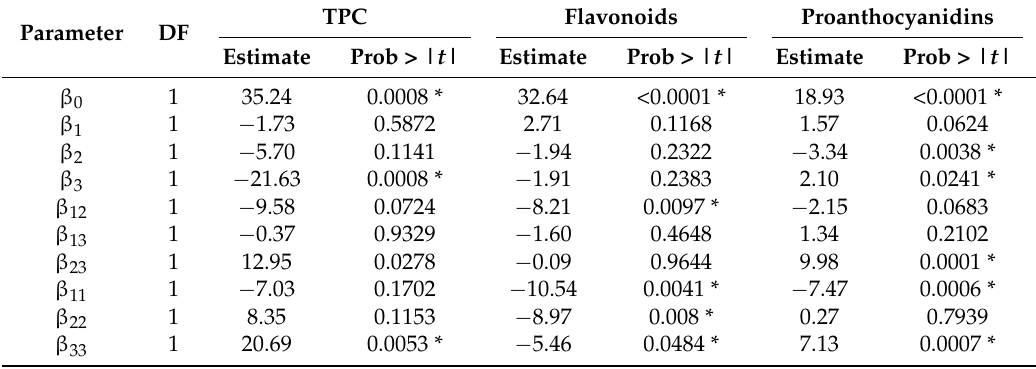
Table 3. Analysis of variance for the experimental results on TPC, flavonoids, and proanthocyanidins.